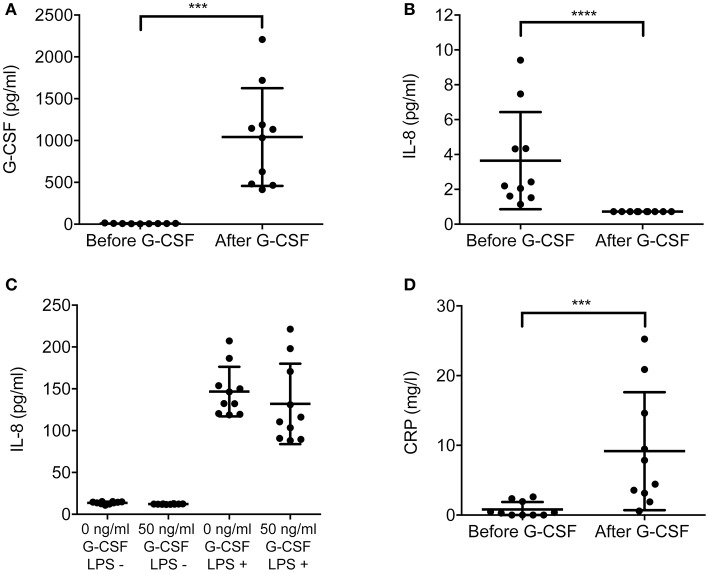
Plasma from G-CSF-treated individuals contains lower amount of IL-8 than untreated controls. G-CSF (A), IL-8 (B), and CRP (D) concentrations in plasma obtained from stem cell donors (n = 10) before and after G-CSF-treatment. Each value was determined from a mean of four technical replicates for G-CSF and IL-8. For IL-8 (B) all the samples after G-CSF treatment were below the range of the assay (0.72 pg/ml). To be able to perform statistical analysis the values were extrapolated to 0.72 pg/ml. (C) Levels of IL-8 secreted by neutrophils in vitro after G-CSF (50 ng/ml) or mock treatment for 30 min and subsequently either stimulated with LPS (1 μg/ml, labeled as LPS +) or left untreated (labeled as LPS -). The levels of IL-8 were measured by ELISA after 6 h stimulation. The CRP values (D) were measured as single measurements for each donor before and after G-CSF treatment. Statistical analysis was performed using a paired students t-test (C) and Mann-Whitney U-test (A,B,D) when data was not normally distributed. ***p < 0.001 and ****p < 0.0001.